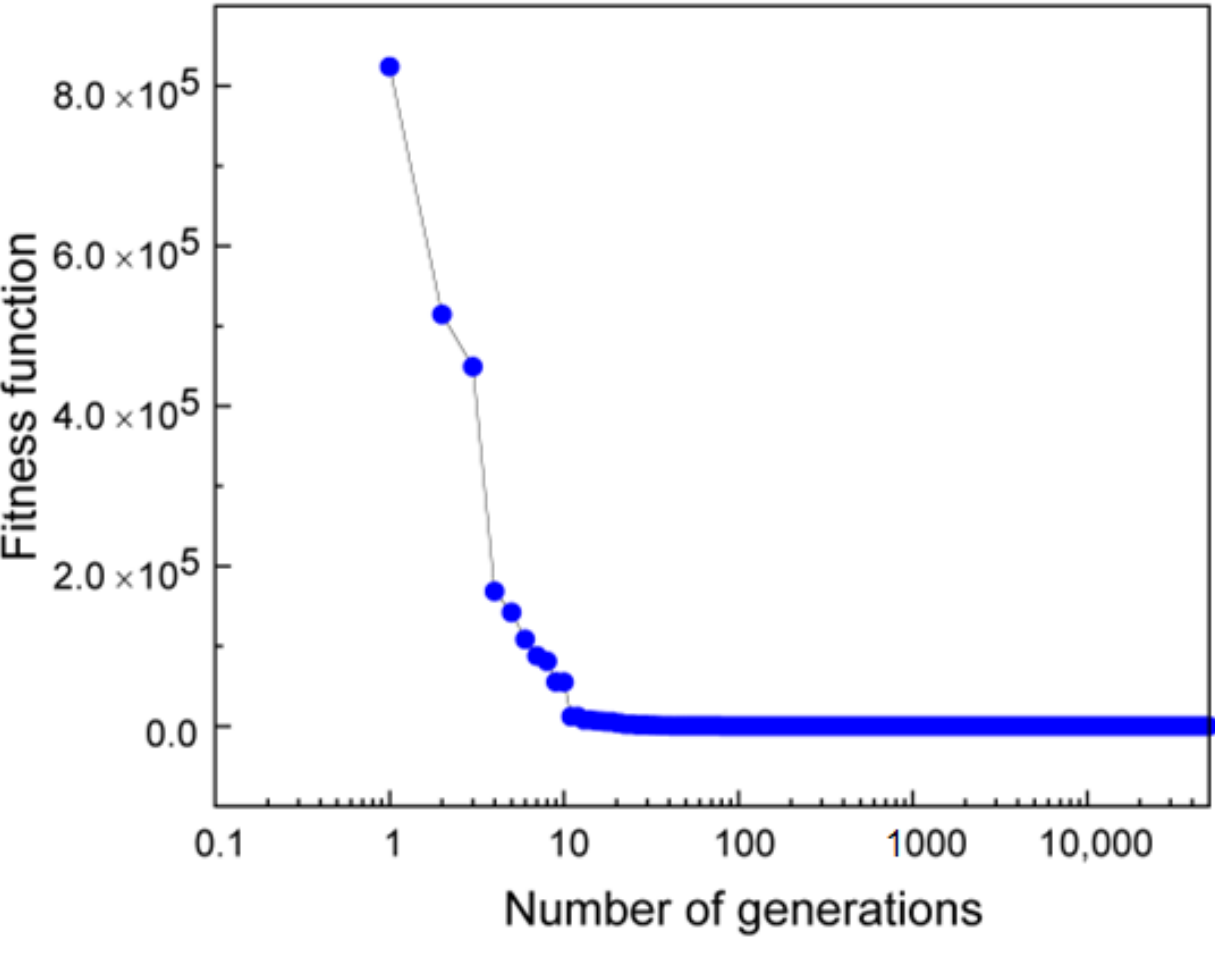
Figure 2. This is a wide figure. Figure 5. A plot showing the decrease in fitness function with the number of generations for Silicon